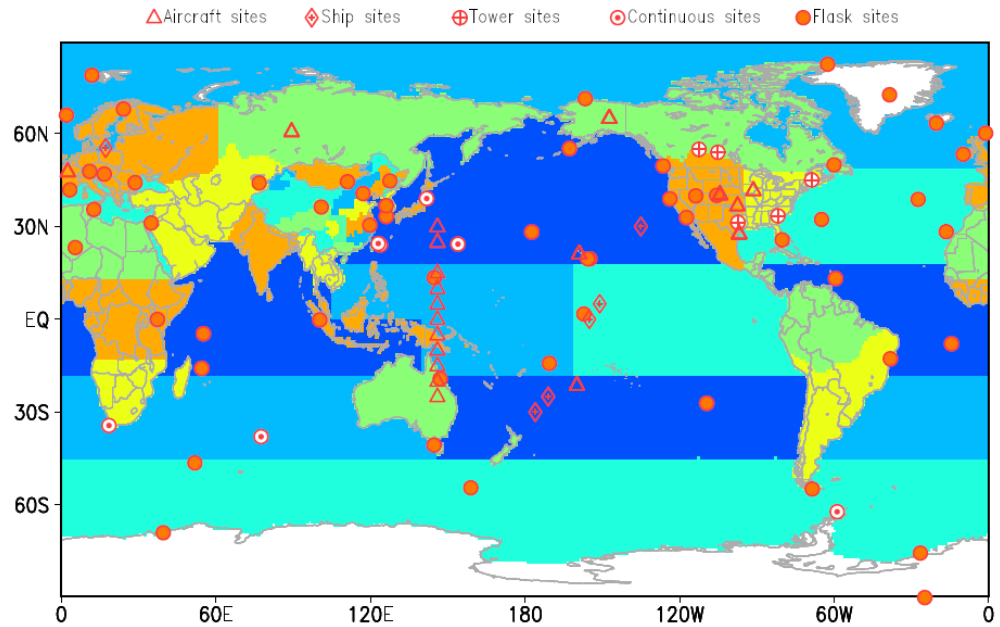
Fig. 2. An inversion scheme: 21 regions in Asia (13 regions in China) and 22 regions for the rest of the globe. Locations of 133 CO 2 observational sites are also indicated, including 57 flask sites, 7 continuous sites, 5 tower sites, 6 ship sites, and 58 aircraft sites.